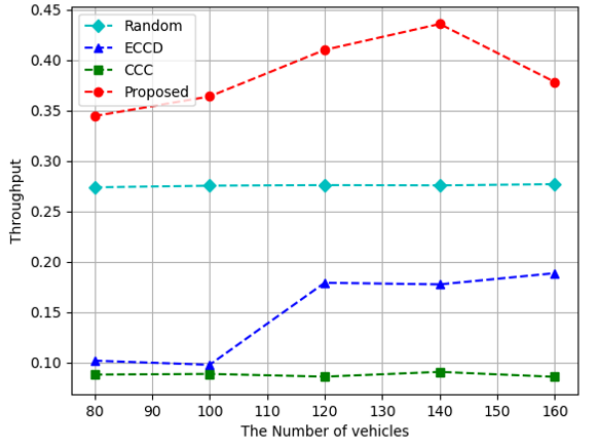
Figure 4. Throughput according to the increase in the number of vehicles.